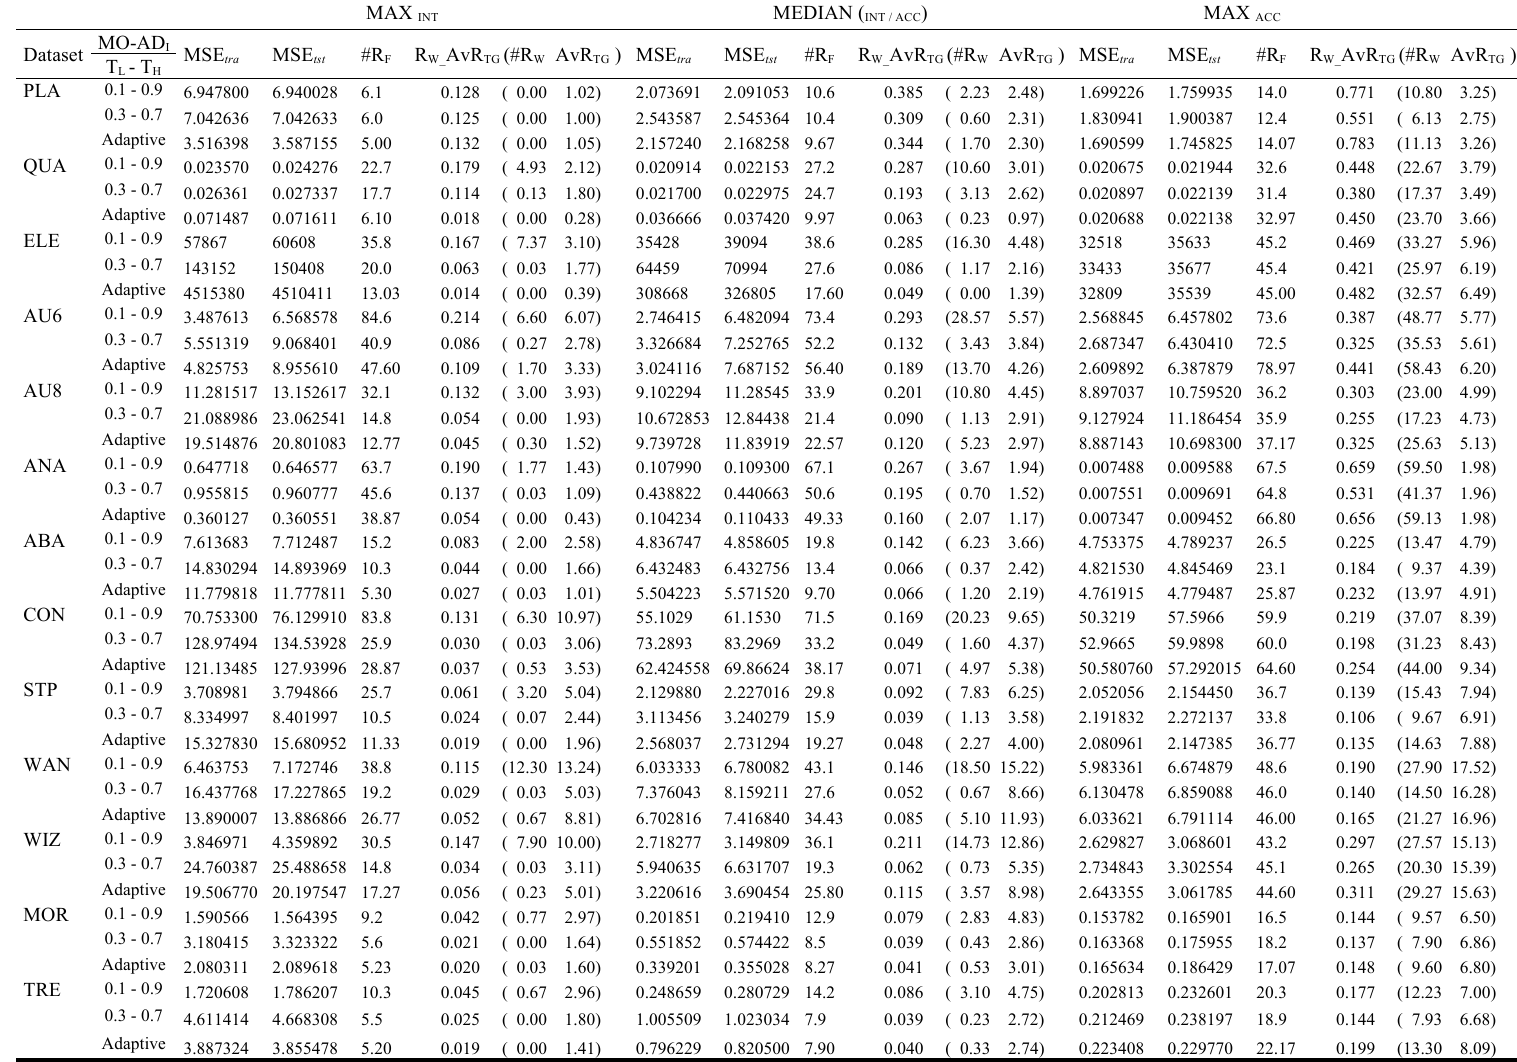
Table 9. Results obtained by MO-AD I for different configurations of thresholds using the WM rule